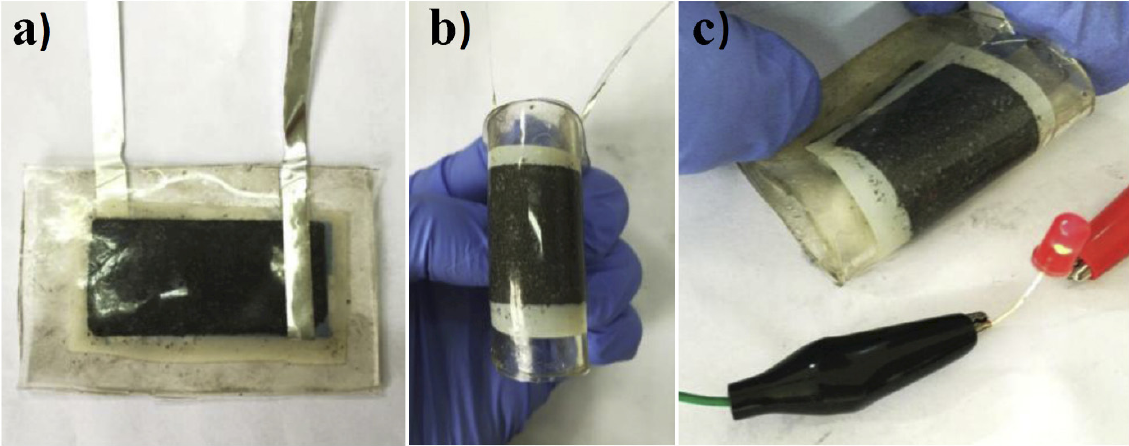
Figure 14. ( a , b ) Photographs of the flat and bent battery encapsulated by PDMS, showing the good flexibility of 3DLG. ( c ) Lighting a red LED device under bending. Reprinted from ref. [74] with permission from Elsevier.